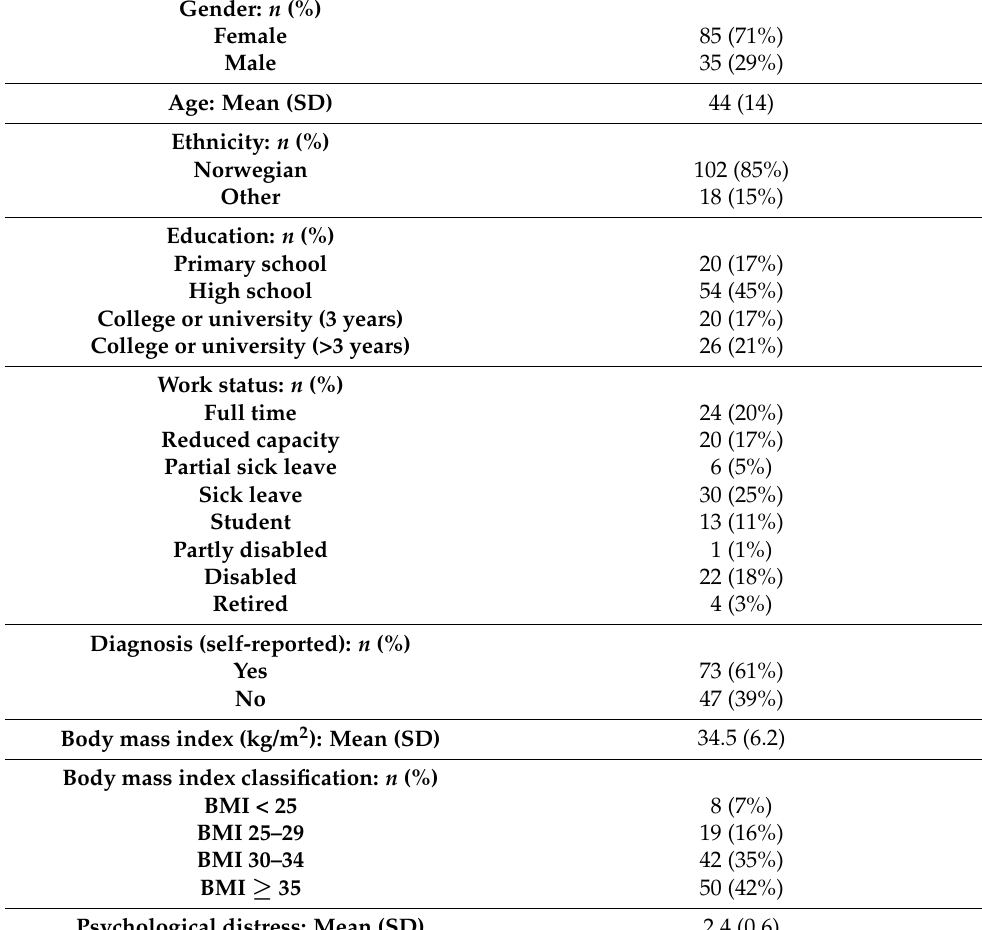
Table 1. Sample characteristics at baseline ( N =